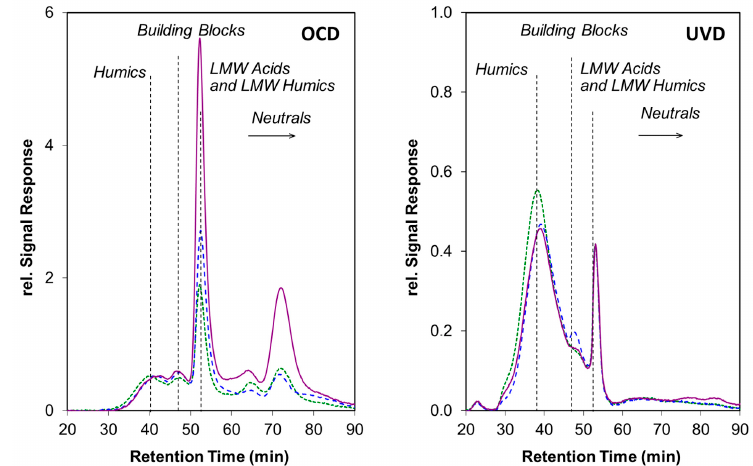
Figure 3. Liquid chromatography coupled to organic carbon detection (OCD) and UV detection (UVD) of Elliot humic acid irradiated at 8.6 (blue line) and 21 × 10 6 J m − 2 (violet line), illustrating the changes in the chemical composition upon irradiation. Non-irradiated control is given in green. The relative proportion of the building blocks and low molar mass neutral molecules increased significantly with radiation intensity. Further details about the light exposure conditions and DOM transformations can be found in Reference [42].